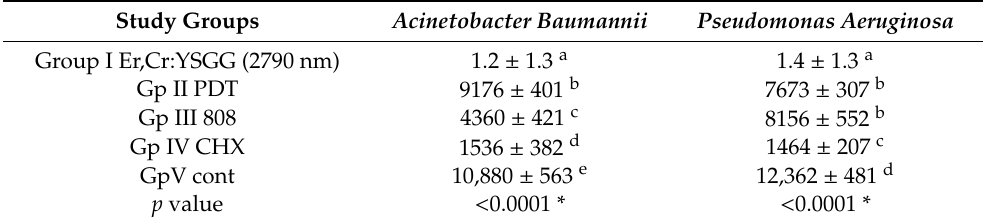
Table 2. Colony forming units (CFU) for the tested bacteria in relation to the different decontamination